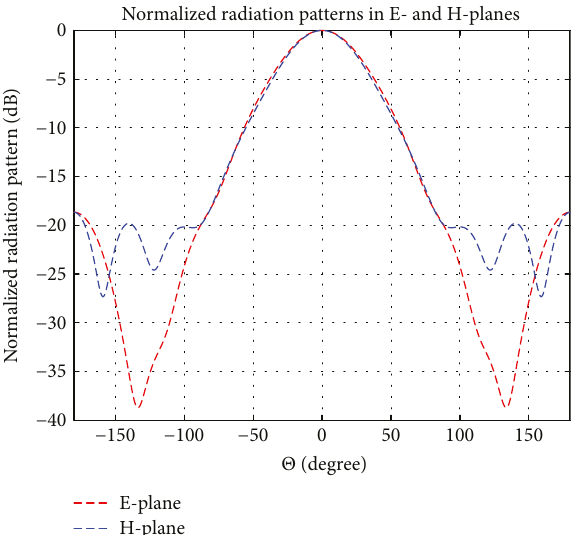
Figure 4: Simulated realized gain versus frequency of the feed.